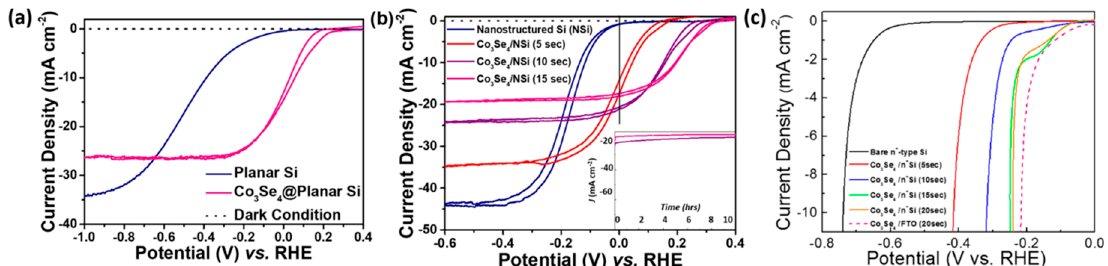
Figure 2. Cyclic voltammograms of electrodeposited Co 3 Se 4 on Si photocathodes: ( a ) Current density ‐ potential curves of bare planar Si photoelectrode and electrodeposited Co 3 Se 4 on planar Si photoelectrode under light condition (solid lines). For comparison, Co 3 Se 4 on Si under dark condition was also displayed (dashed line). ( b ) Photocurrent density ‐ potential curves according to electrodeposition time of Co 3 Se 4 under light illumination condition. Inset image indicates chronoamperometry results from selected photocathode samples for the stability test. Co 3 Se 4 /NSi (15sec) at the potential 0.2 V vs. RHE (pink color) and Co 3 Se 4 /NSi (15sec) at the potential 0.1 V vs. RHE (purple color). ( c ) Dark current density ‐ potential curves of Co 3 Se 4 film on highly P ‐ doped n + ‐ type Si electrodes with increasing electrodeposition time of Co 3 Se 4